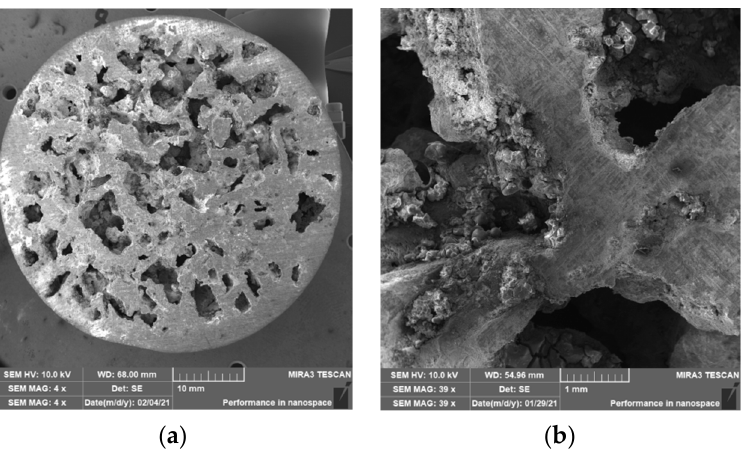
Figure 11. View of the structure of the porous material of AlSi12 alloy: ( a ) detail of the material; ( b ) scanning electron microscope image (Vega 3 Tescan, SEM HV 20.0 kV) of sample SAM3.